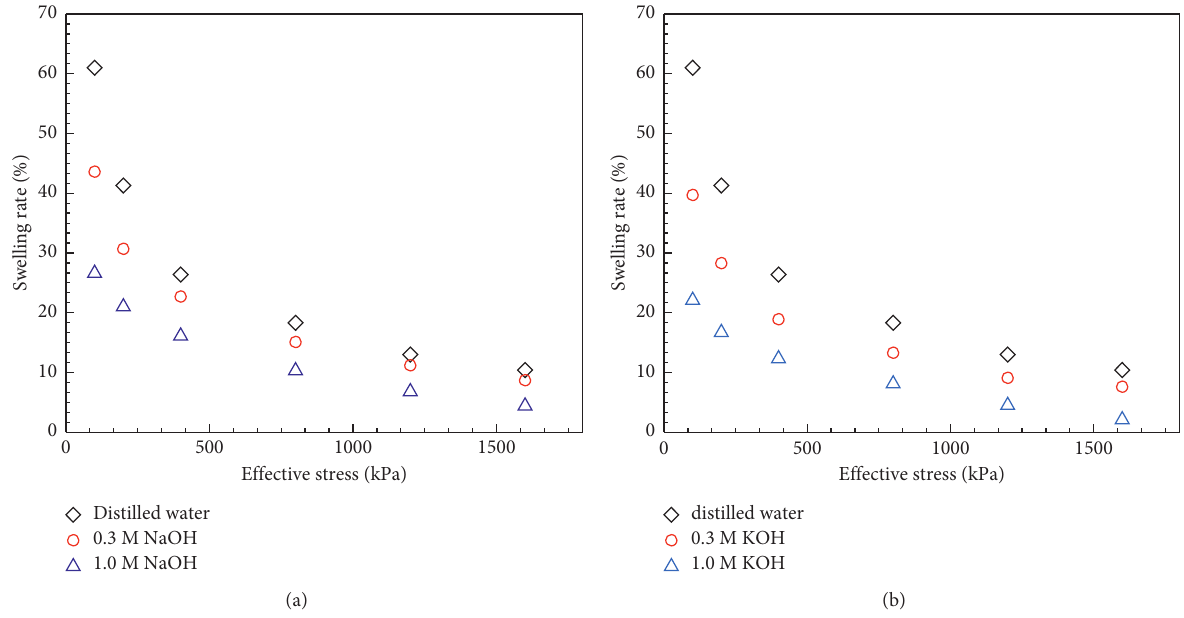
Figure 3: The relationship curve of maximum swelling deformation with load.